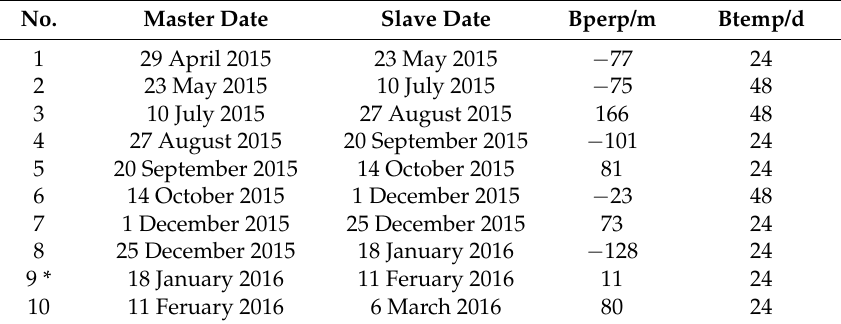
Table 1. Sentinel-1A IW mode SAR images pairs for